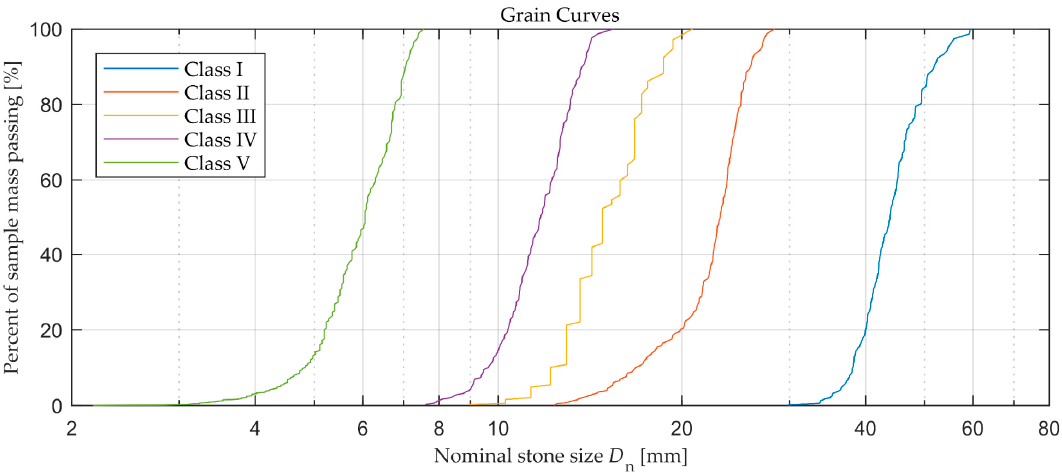
Figure 4. Grain curves of the rock material used in the present tests.